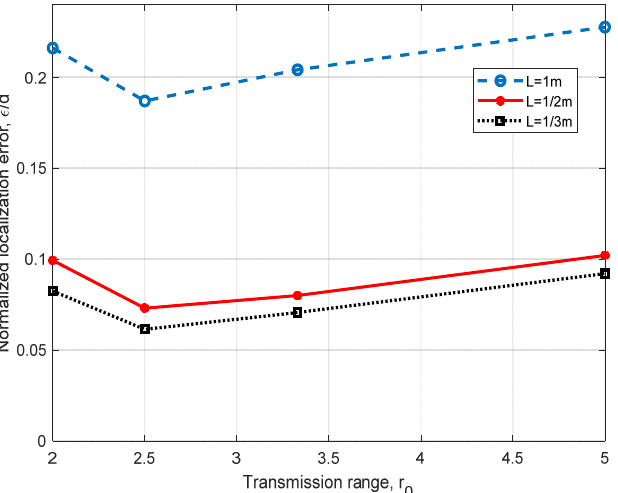
Figure 9. Error analysis for different values of the discretization unit L and different transmission ranges r 0 , using four ANs in a 3D scenario, for d = h = 10 m. Table 5. Entropy analysis for 4 ANs with different transmission ranges, r 0 , and discretization unit L .